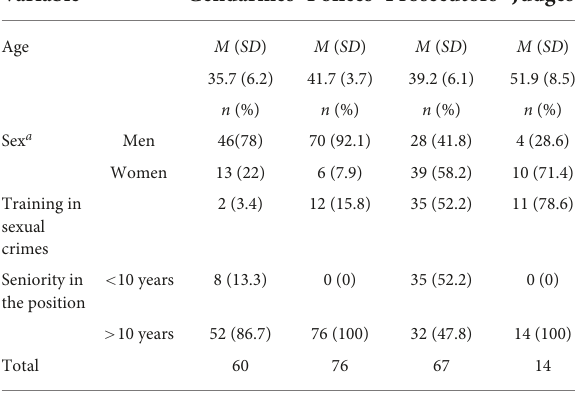
TABLE 1 Socio-demographic characteristics of the participants.